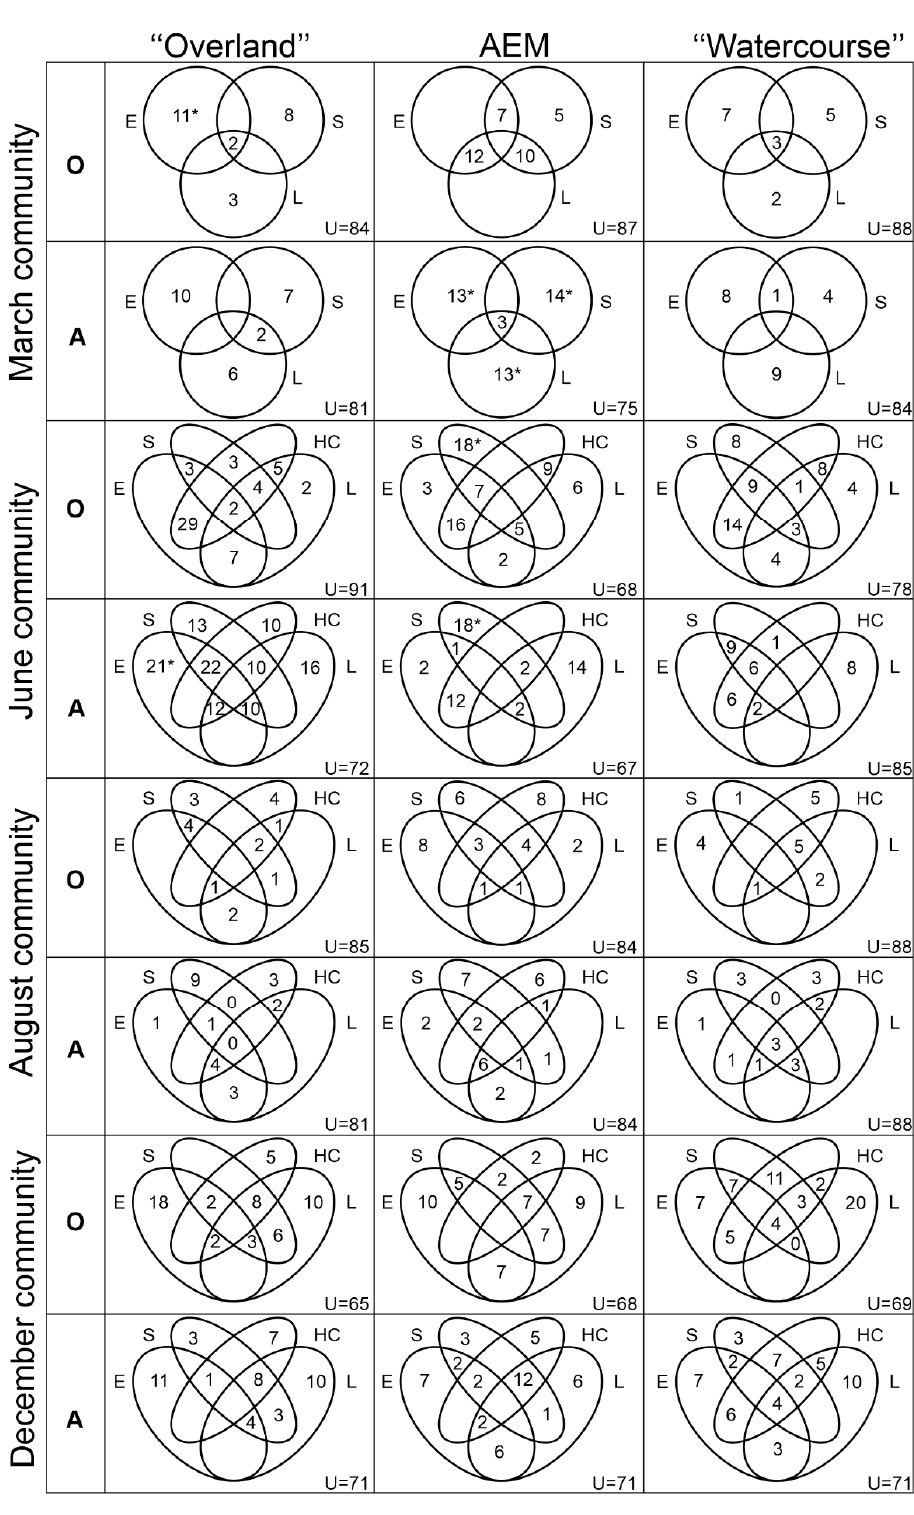
Figure 5. Results of the Partial Redundancy Analysis (pRDA). Relative contributions (% explanation) of environmental (E), spatial (S), historical community (HC) and landscape (L) that explain the variation in relative abundance (A) and Occurrence (O) of periphytic diatom metacommunities. We used possible dispersal routes “overland”, “AEM”, and “Watercourse” as spatial predictors (see methods). U = unexplained component. Values < 0.5% were not shown. Explanation percentages significantly different from a null model ( p < 0.05) are represented by “*”.